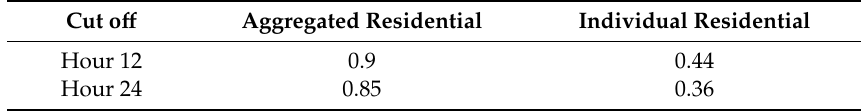
Table 1. P index based on annual data for residential customers. Cut o ff Aggregated Residential Individual Residential Hour 12 0.9 0.44 Hour 24 0.85